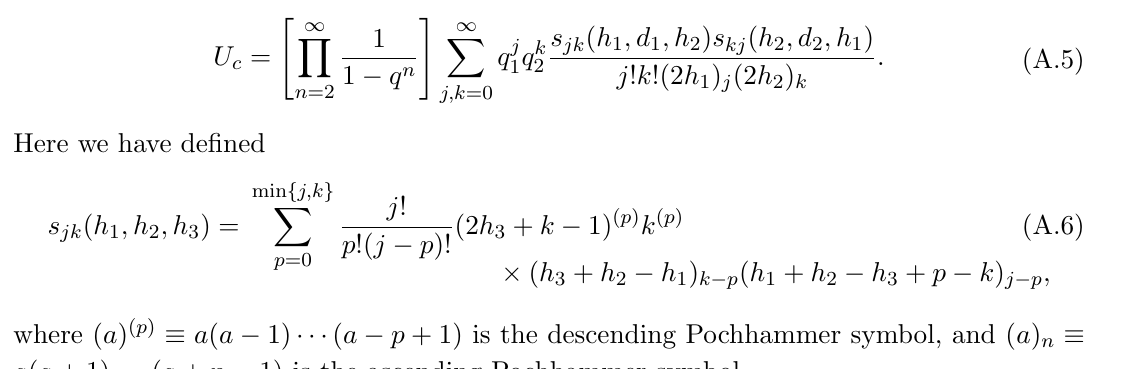
and q can be extracted e(cid:14)ciently. The 1 2